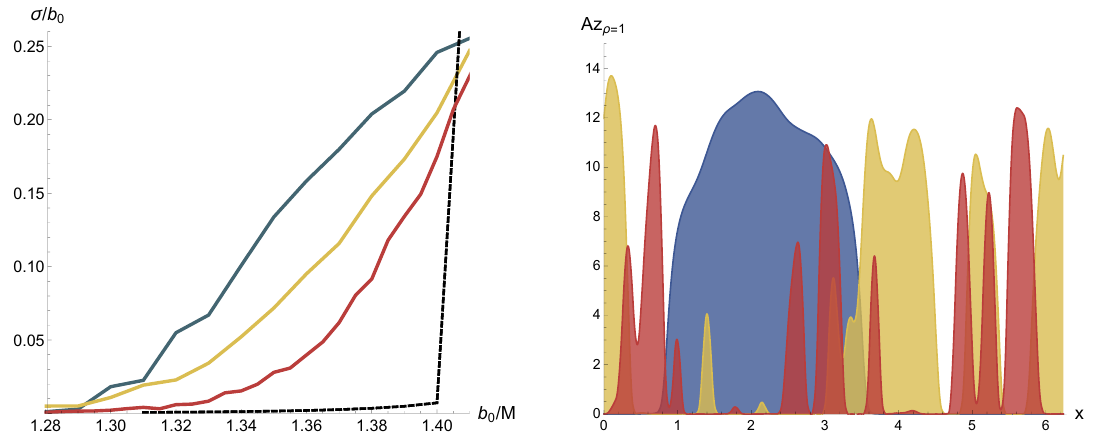
Figure 8 . Left: anomalous Hall conductivity as a function of vs (cid:22) b 0 for (cid:22) (cid:13) 2 [0 : 003 ; 0 : 035] (blue-red). Right: semilogartihmic plot of the AHC against (cid:22) b 0 for (cid:22) (cid:13) 2 [0 : 001 ; 0 : 035] (green-red). Black lines correspond to the exponential (cid:12)t (3.3).